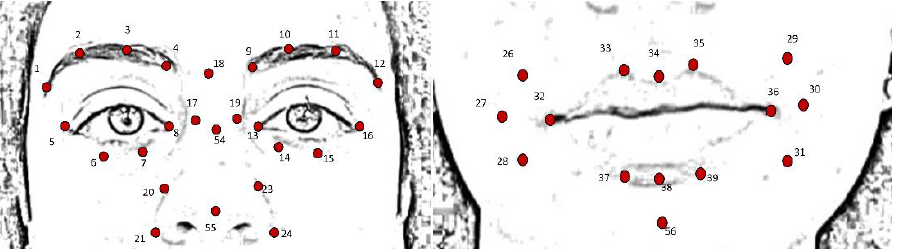
Figure 2. Landmark description: from 1 to 16 features describing the eyes, from 17 to 24, 54 and 55 describing the nose, from 25 to 39 and 56 describing mouth and cheeks.